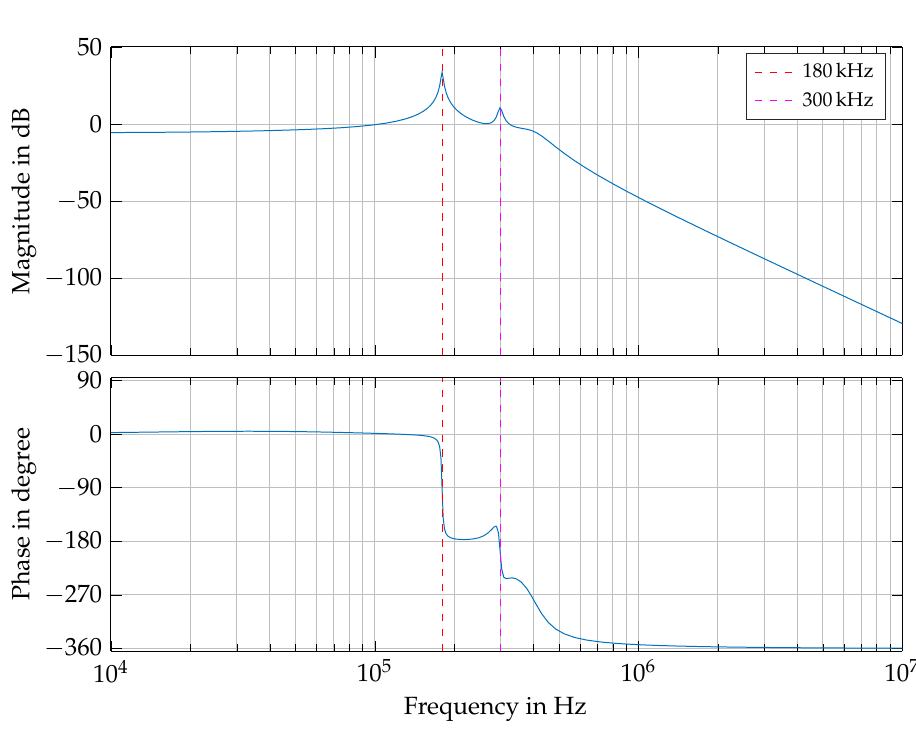
Figure 6. Bode plot of the transfer function G A ( s )